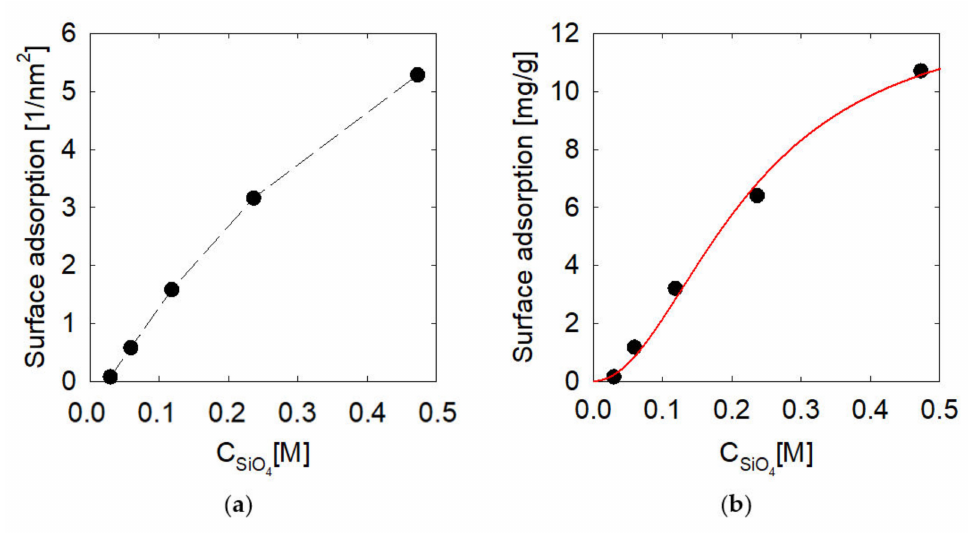
Figure 5. Mean surface adsorption of metasilicate on hematite (001) surface at different metasilicate concentrations. ( a ) in silicate molecules by nm − 2 and ( b ) in mg of silicate by g of hematite with the fitted sips model.